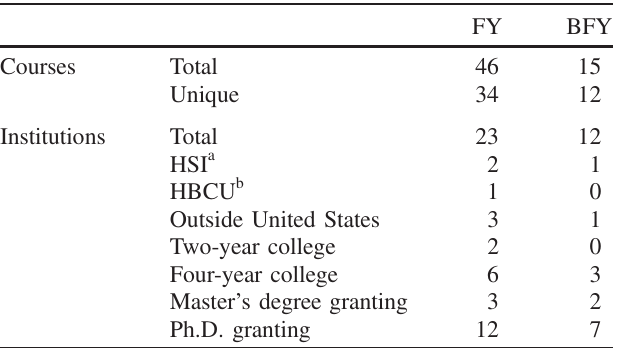
TABLE III. Number of courses and institutions of each type attended by the students in this study who conducted their lab courses